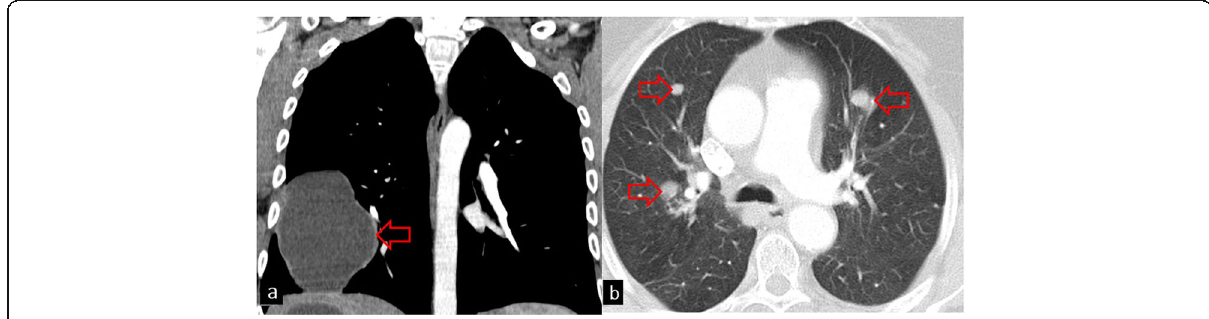
Fig. 2 a Coronal chest CT image in the mediastinal window shows a giant (> 10 cm) uncomplicated hydatid cyst (red arrow). Measurement of HU values on CT shows low density (mean HU ± SD = − 1 ± 10) consistent with simple fluid. b On axial CT image, bilateral hydatid cysts are seen (red